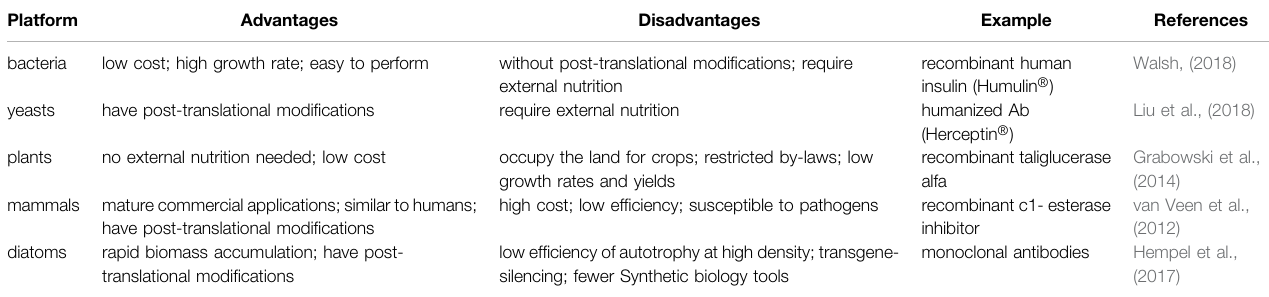
TABLE 1 | Advantages and disadvantages of different types of cell